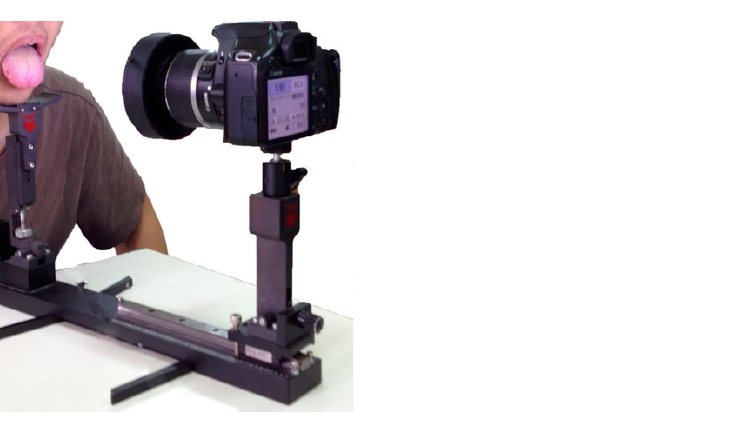
Figure 2. Illustration of tongue image capturing with the Automatic Tongue Diagnosis System (ATDS) (adapted from [39]).